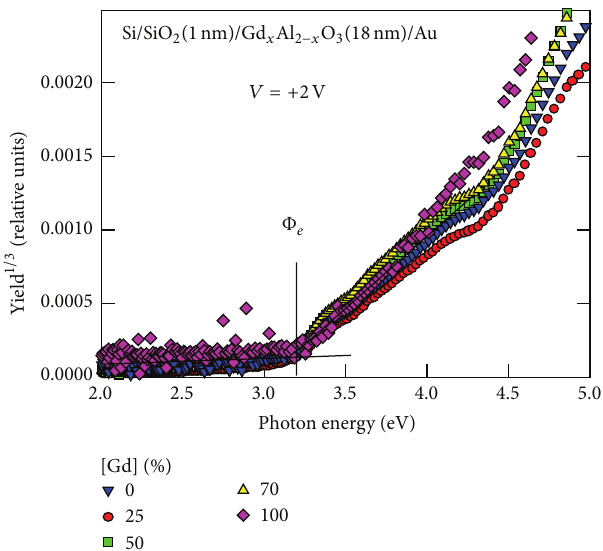
Figure 12: Cube root of the IPE yield as a function of photon energy plot used to find the spectral threshold Φ 𝑒 of electron IPE from the VB of Si into the CB of Gd 𝑥 Al 1−𝑥 O 3 is indicated by vertical